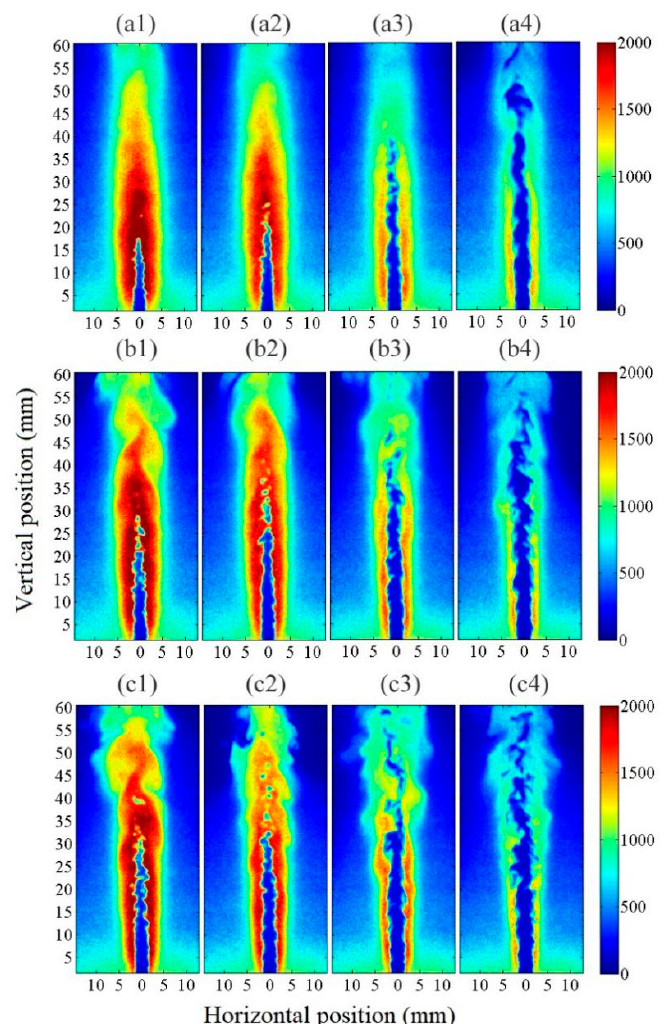
Figure 7. OH distribution instantaneous image of syngas with volumetric ratio of 50%H 2 –50%CO under different dilutions and Reynolds numbers: ( a1 – a4 ) Re = 6110; ( b1 – b4 ) Re = 10,690; ( c1 – c4 ) Re = 15,270. 1,2,3, and 4 indicate nitrogen dilution volumetric proportion of 0%, 10%, 30%, and 50%, respectively.